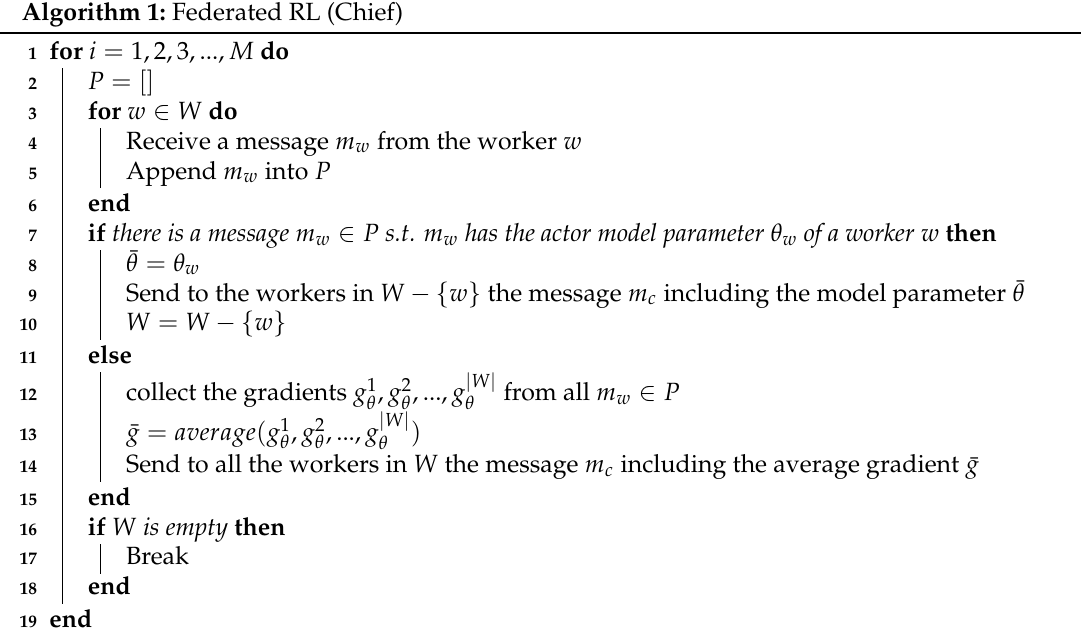
Algorithm 1: Federated RL